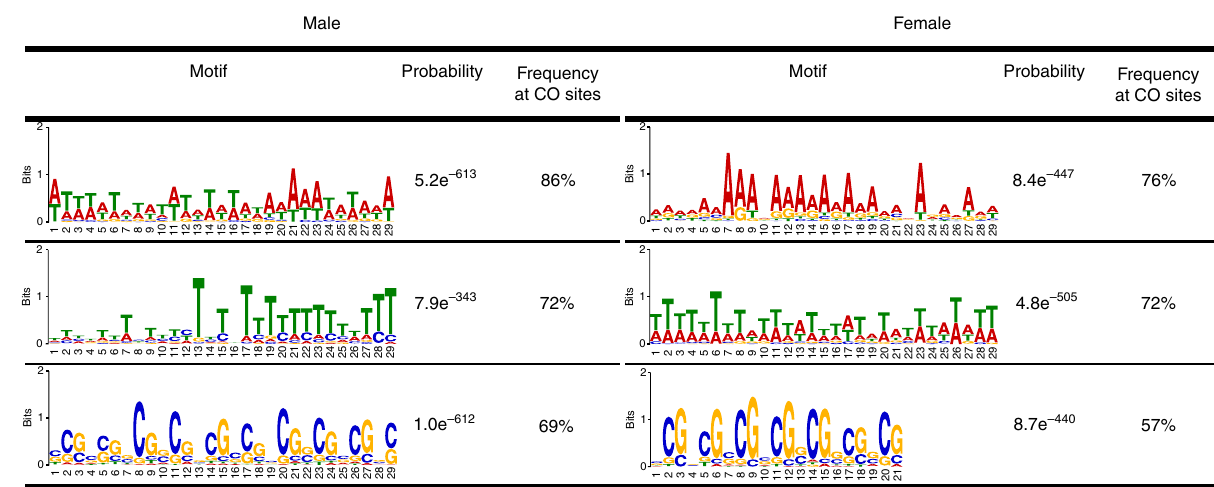
Fig. 2 Comparison of DNA sequence motifs associated with CO sites in male and female meioses in the B73 × Mo17 hybrid. Probability values are log – likelihood